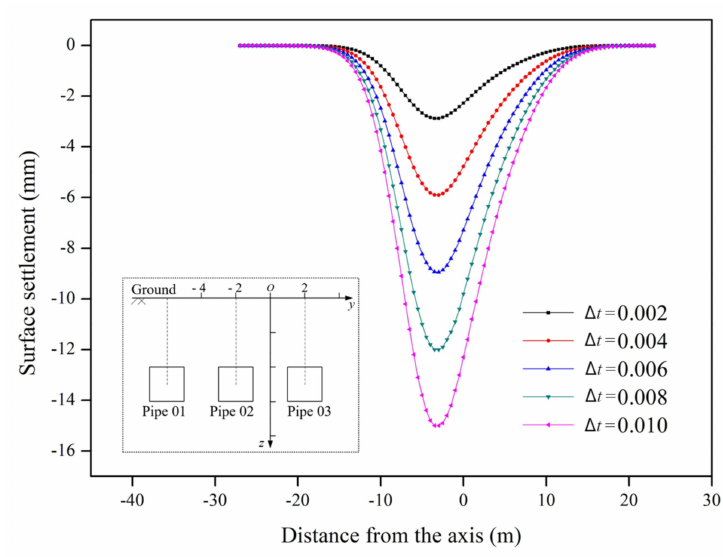
Figure 17. Curves of transverse surface settlement.